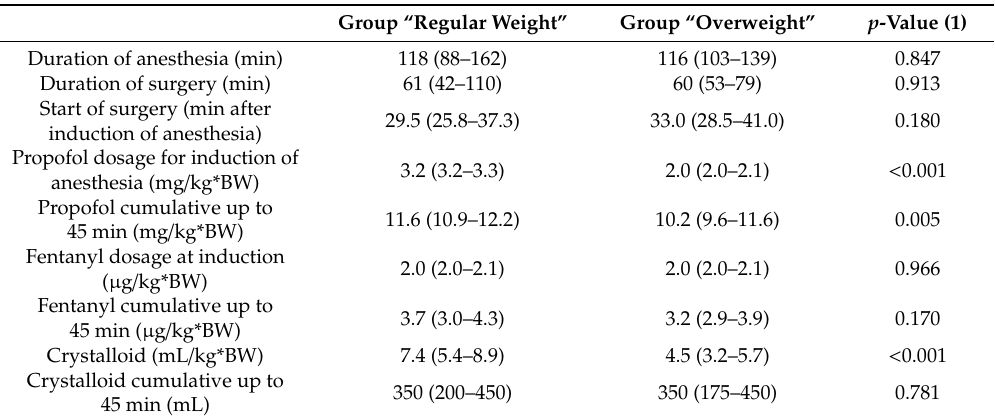
Table 2. Anesthesia-related parameters (median (interquartile range (IQR)); (1) Mann–Whitney U test; BW: body weight).